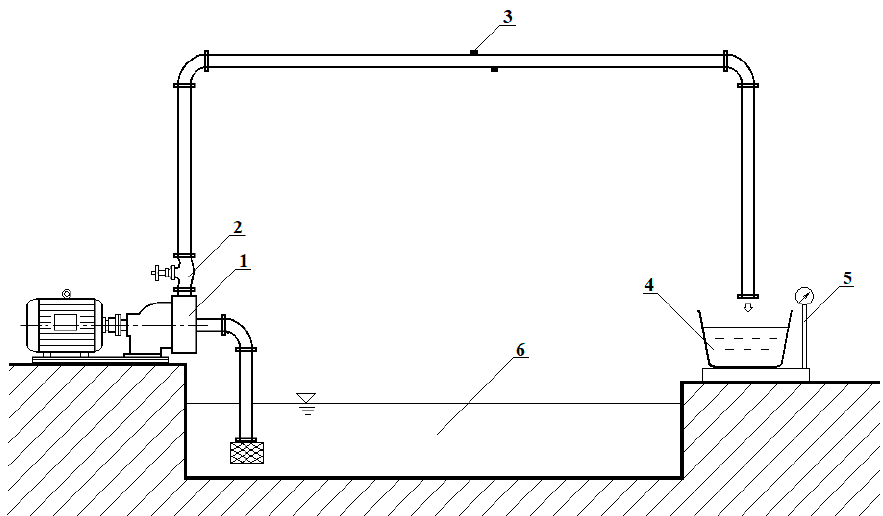
Figure 5. The performance testing system for centrifugal pumps. 1-centrifugal pump; 2-regulating valve; 3-ultrasonic transducers; 4-water tank; 5-electronic scale; 6-water